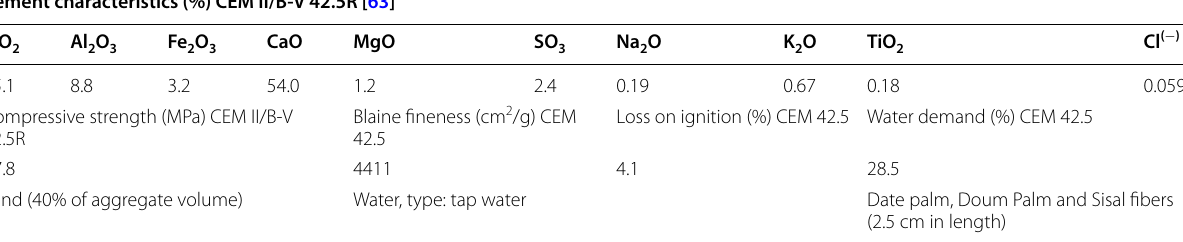
Table 2 The physico-chemical characteristics of the Mortar [63] Cement characteristics (%) CEM II/B‑V 42.5R [63] SiO